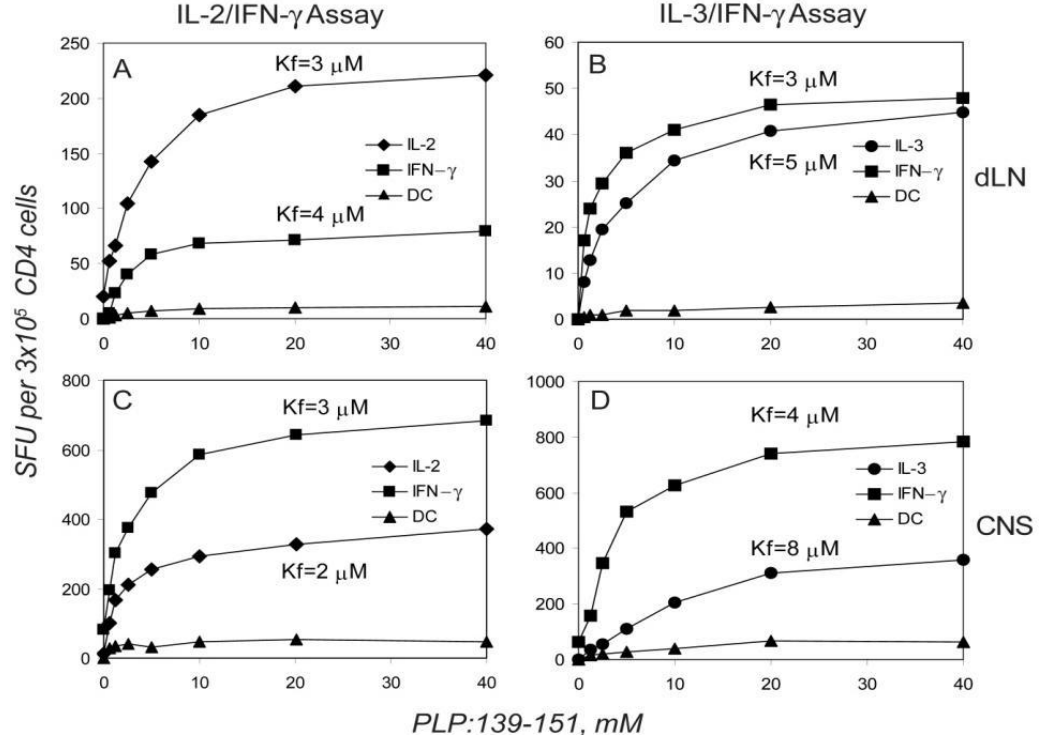
Figure 4. Dissociated production of IL-2, IL-3, and IFN- (cid:534)(cid:3)(cid:69)(cid:92)(cid:3)(cid:51)(cid:47)(cid:51)(cid:29)(cid:20)(cid:22)(cid:28) -151-specific CD4 T cells is independent of the peptide dose used for T cell activation; the single cytokine producing CD4 cells have similar functional avidities. Twelve days after immunization, CD4 cells were isolated from dLN (A,B) and mononuclear cells were isolated from the spinal cord (C,D) of SJL mice during the first episode of paralytic encephalomyelitis (EAE). The numbers of single and double-cytokine-producing cells within the 3 × 10 5 cells plated per well are plotted vs . the peptide concentrations used for stimulating the CD4 cells. peptide concentration leading to the 50% from maximum activation (Kf) defining functional avidity is shown for each single-cytokine dose-response curve (for details see Experimental Procedures). Data shown represent mean values measured from triplicate wells in one of 4 representative experiments. The standard deviations for all data points were less than 5% (comparable in size to symbols used) and are not